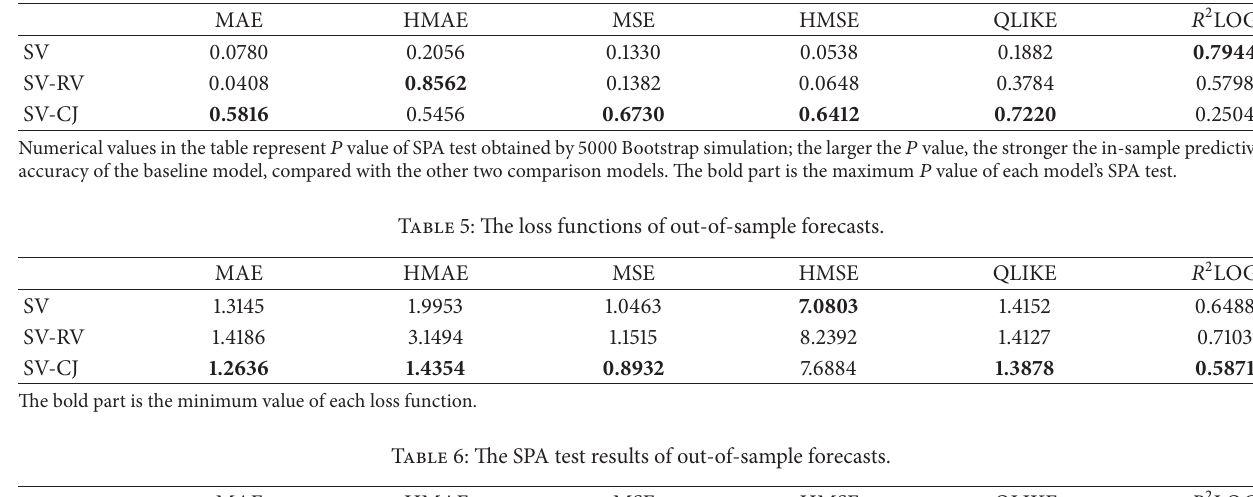
Table 4: The SPA test results of in-sample forecasts.